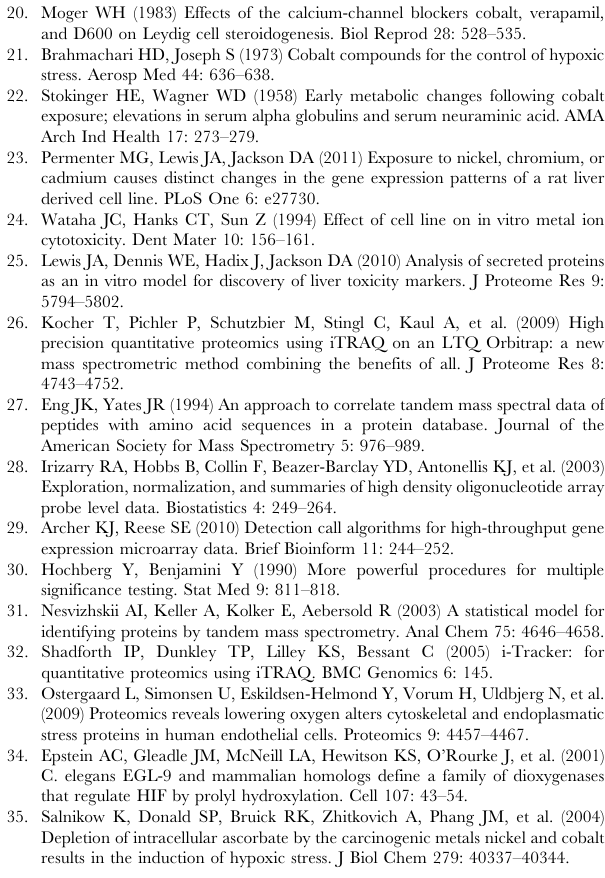
Figure S1 Cell viability assay results for rangefinding. Cell viability rangefinding studies were conducted to ensure that concentrations used for gene expression analysis were at sub-lethal concentrations. The points not connected to a line denote the low and high concentrations used in the definitive studies. Figure S2 qPCR results used for rangefinding. We determined the gene expression for a panel of genes using semi- quantitative qPCR to aid in selecting doses for the definitive experiment. The points not connected to a line denote the low and high concentrations used in the definitive studies. Table S1 Differentially expressed probe sets. We considered a probe set to be differentially expressed with a FDR # 0.01 and a fold change of at least 1.8 from control. Each worksheet lists the differentially expressed genes for each cell line at each concentra- tion, with the last worksheet listing the 214 common differentially expressed probe sets.